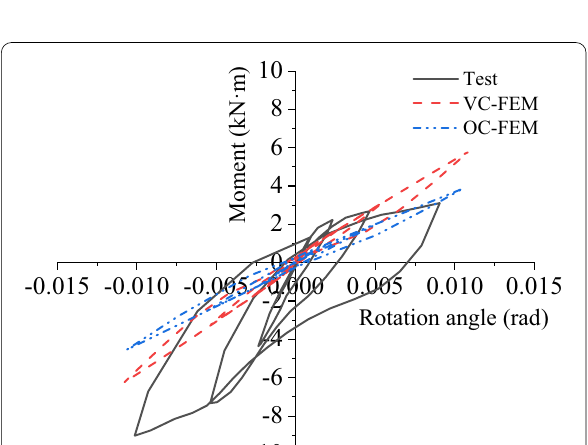
Fig. 24 Failure patterns of straight tenon joint in test